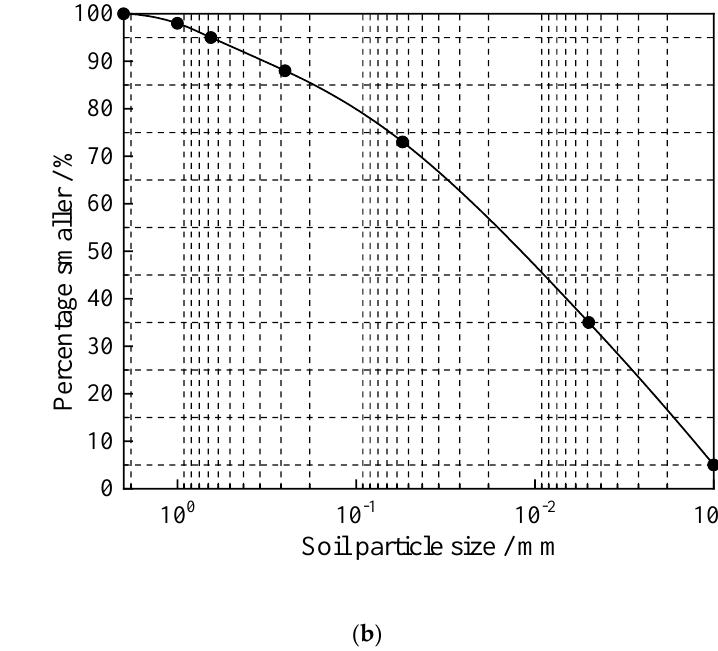
Figure 2. Soil specimen and grain distribution curve. ( a ) Soil specimen, ( b ) particle size distribution curves.